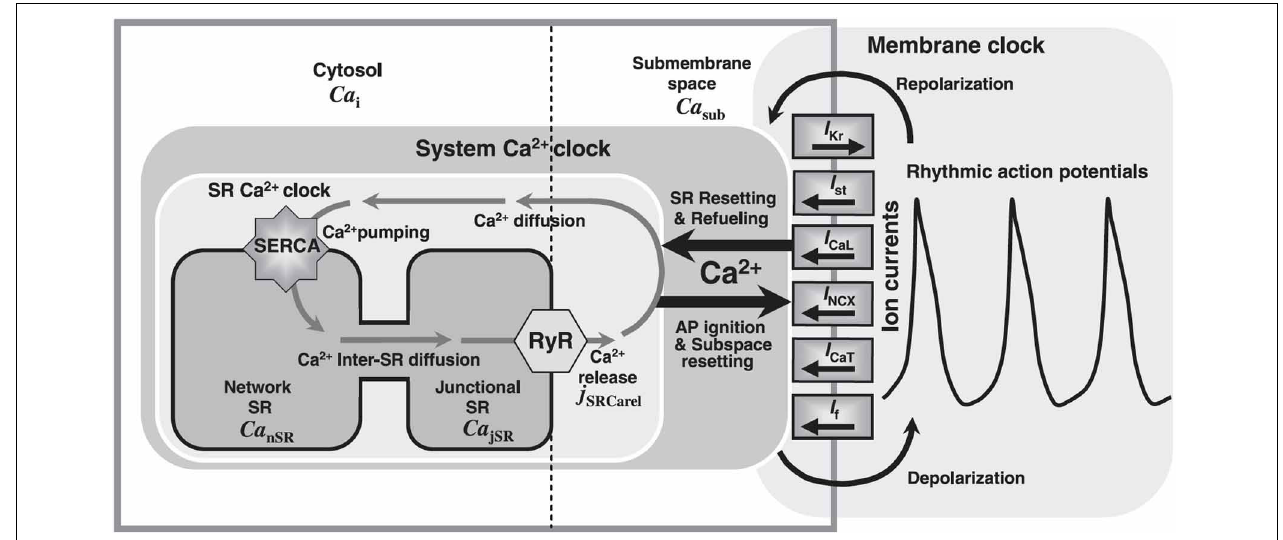
FIGURE 6 | Model schematic of the ML SAN cell model, figure modified from (32). Ca i : Ca 2 + in bulk cytosol; Ca sub : Ca 2 + in the subspace; SERCA: SR Ca 2 + pump; Ca nSR : Ca 2 + in the network SR (nSR); Ca jSR : Ca 2 + in the junctional SR (jSR); j SRCarel : SR Ca 2 + release